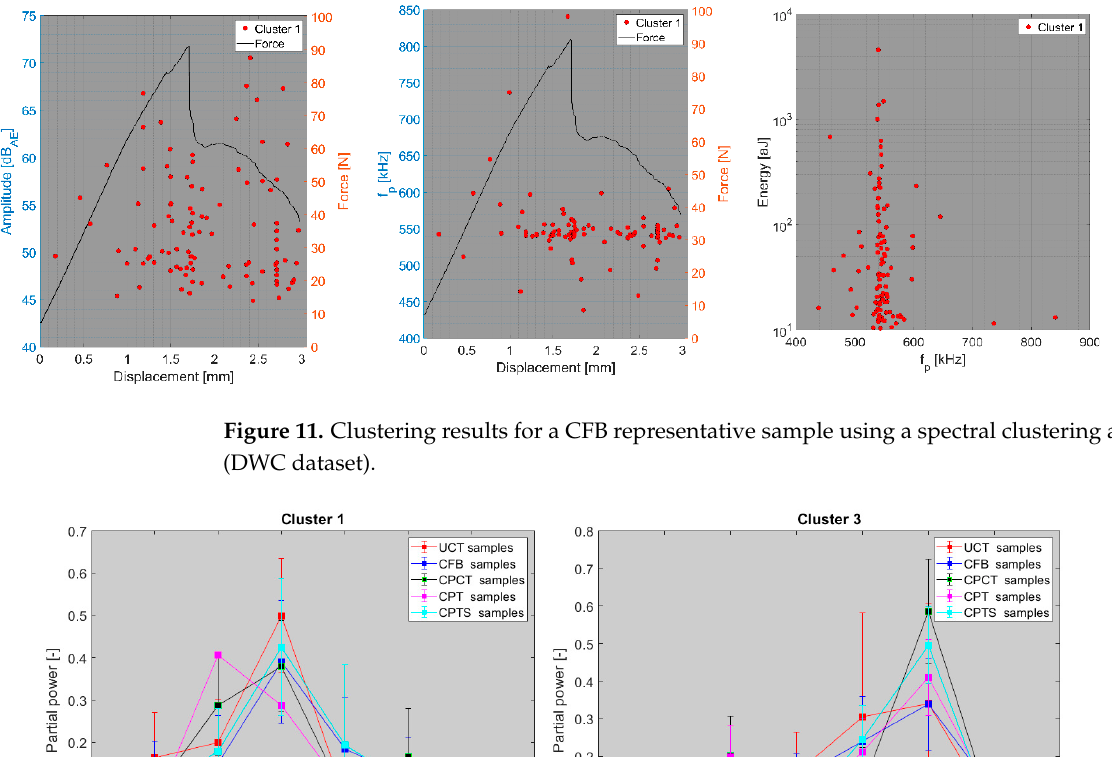
Figure 10. Clustering results for a CFB representative sample using a spectral clustering algorithm (Fujicera 1045S dataset).